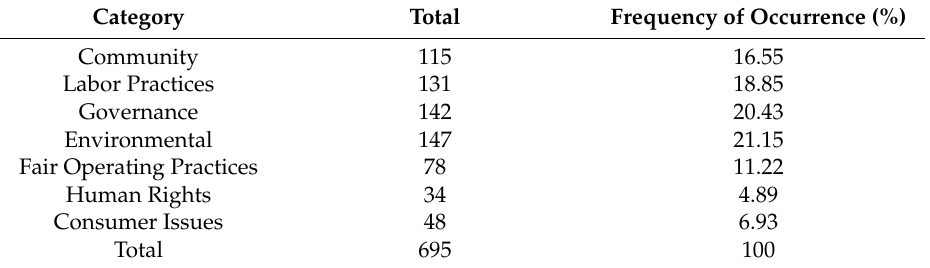
Table 3. Number of strategies per category in all the reports and the frequency of occurrence of each